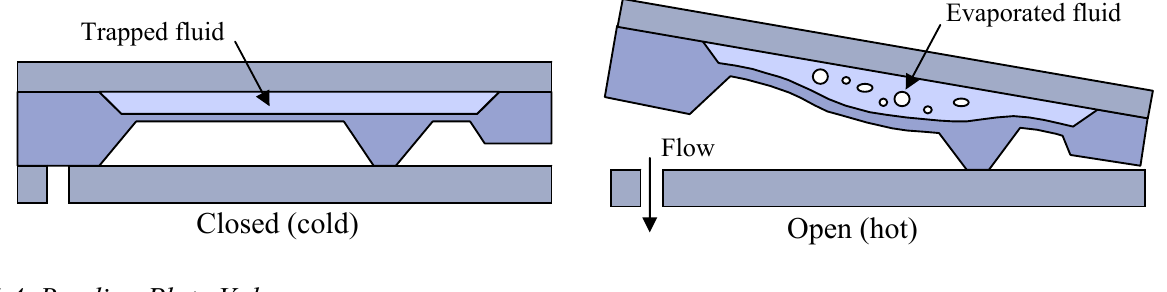
Figure 6. Design and operating principle of the NC-1500 Fluistor, a commercially available tilting plate microvalve [25].